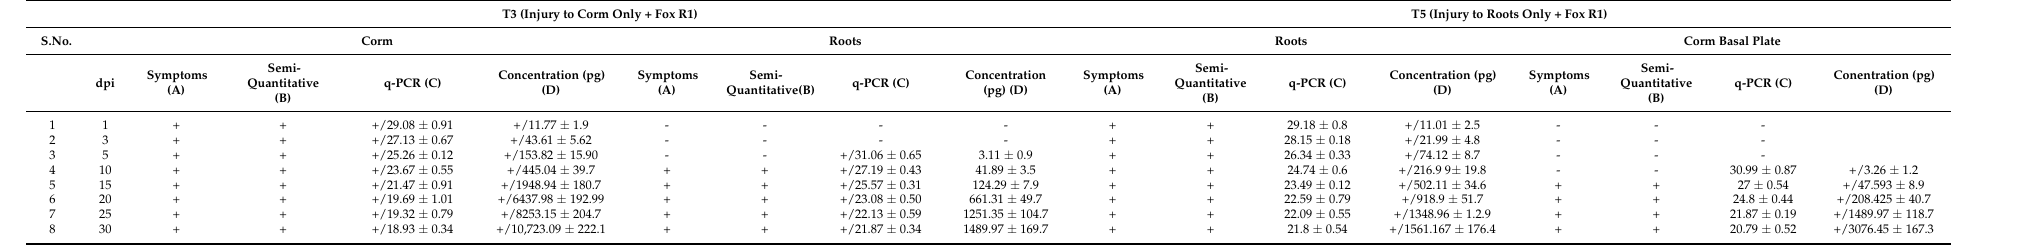
dpi-days post inoculation. (A); (+) indicate symptoms visible to naked eyes, (-) indicate no visible symptoms, (B); (+) indicate amplicon size of 100 bp obtained, (-) indicate no amplification, (C); (+) indicated Ct value < 34, (-) indicated Ct > 34,(D); values are the concentration of Fox R1 (pg/µL) unknown samples determined from the standard curve. Table 4. Quantification of Fox R1 in infected roots and corms at different days post inoculation using Fox R1-specific primers. T3(InjurytoCormOnly+FoxR1) T5(InjurytoRootsOnly+FoxR1)